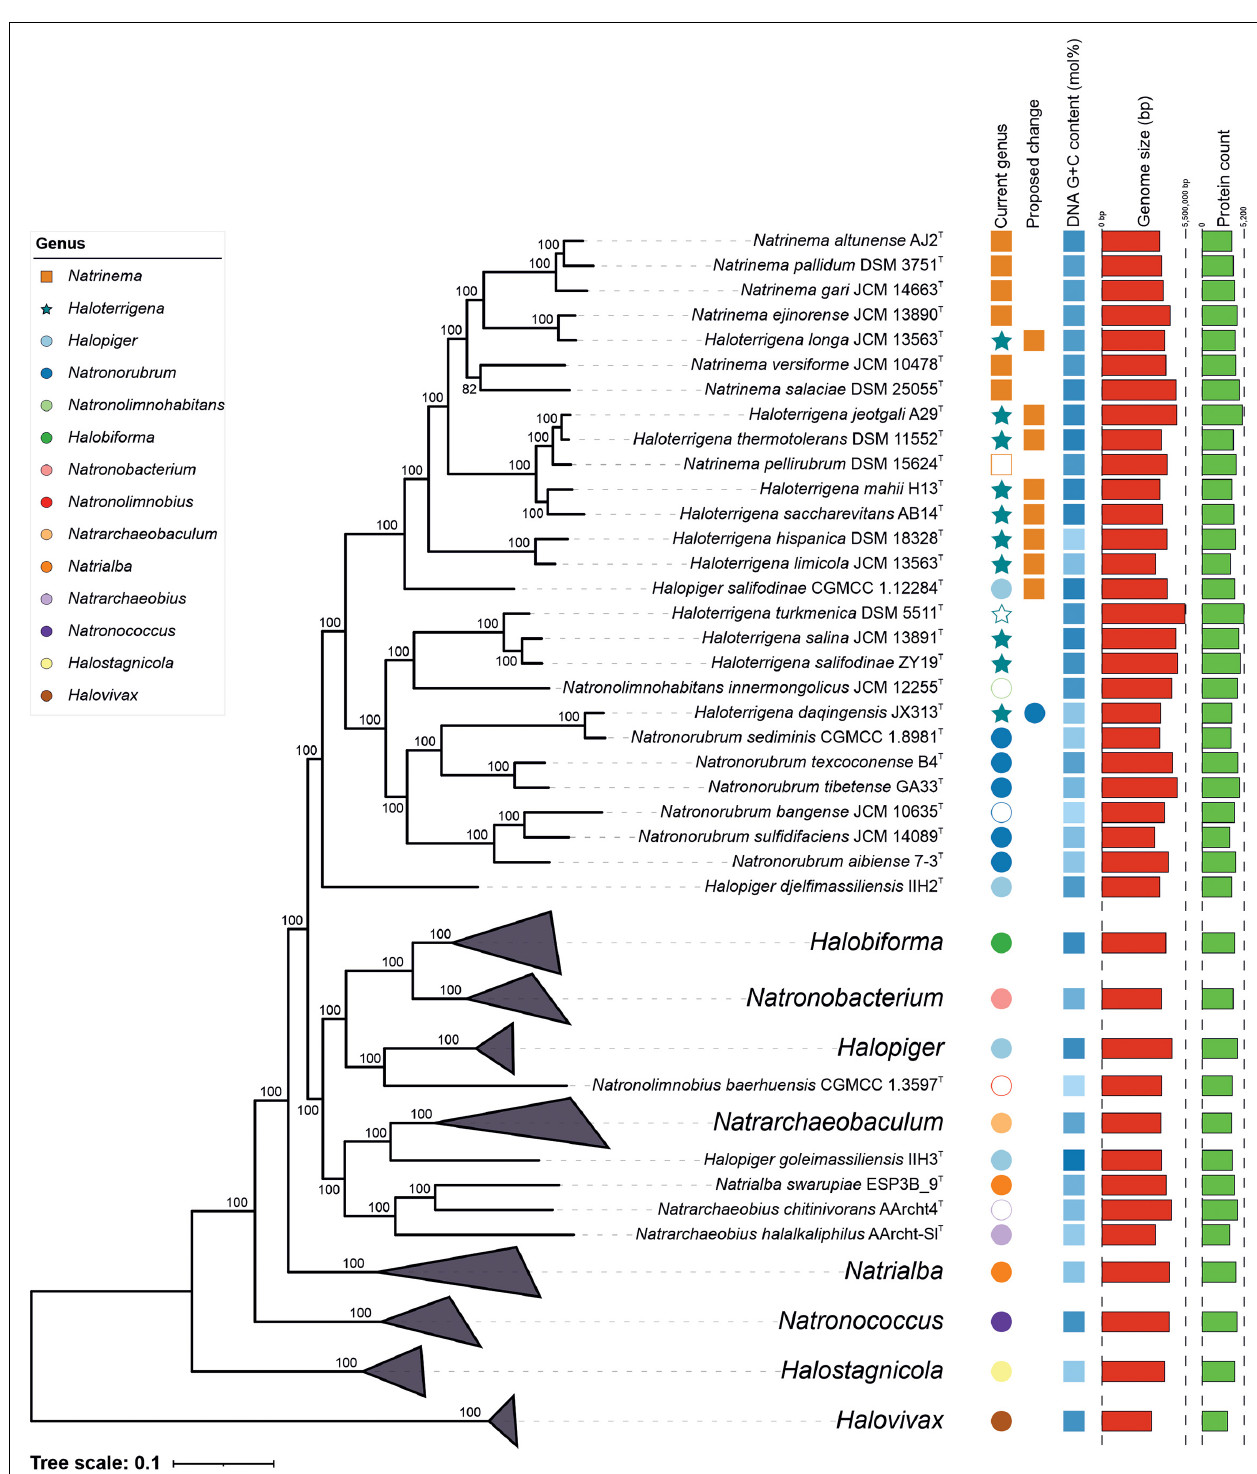
Frontiers in Microbiology |